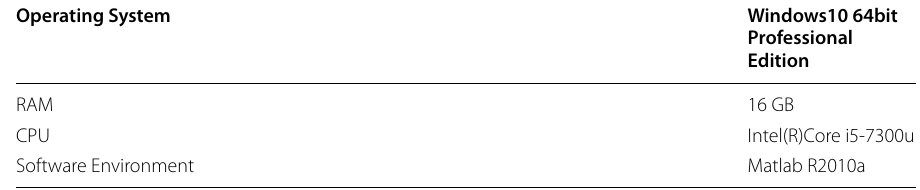
Table 2 System and software